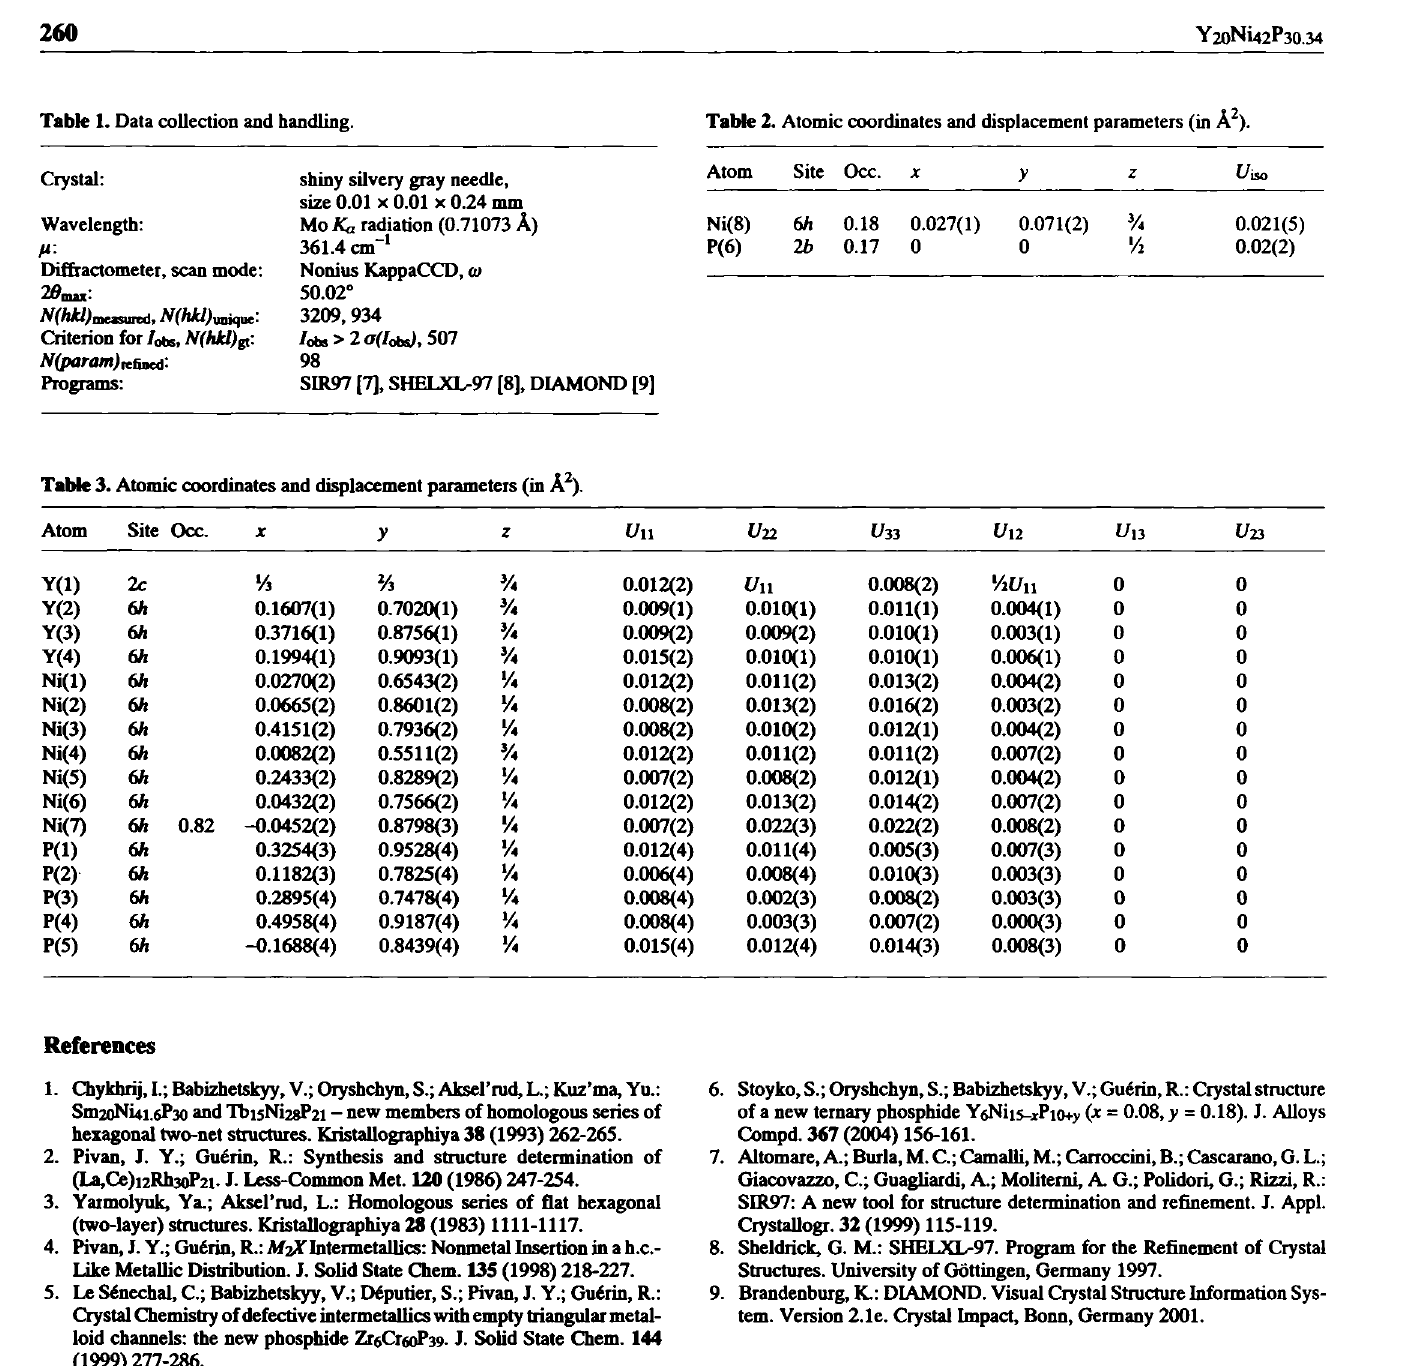
Table 1. Data collection and handling. Table 2. Atomic coordinates and displacement parameters (in Ä 2 ).